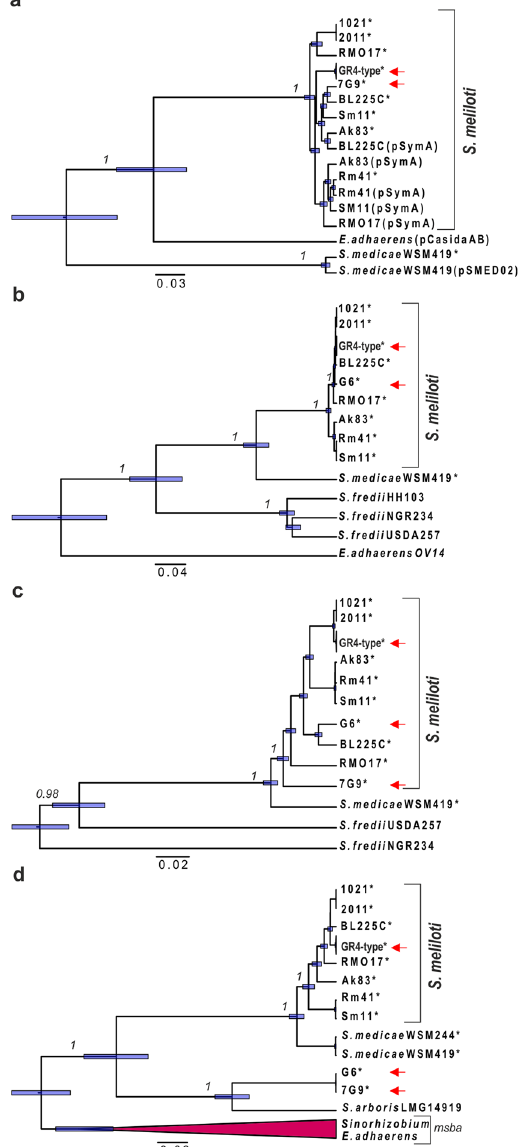
Figure 5. Species trees for GID core genes. The maximum clade credibility tree estimated with BEAST 2, based on the alignment of core loci (Supplementary Data 4–7) located at the left and right boundaries of the GID, and internal genes with higher levels of nucleotide diversity conserved in Sinorhizobium species. ( a ) Peptidase T (left boundary, WP_015243214.1). ( b ) Diguanylate cyclase (right boundary, WP_015243358.1). ( c ) Sensor histidine kinase (WP_015243309.1) within Region 5. ( d ) multidrug ABC transporter ATPase/ permease (WP_015243259.1) within Region 3. We included paralogous msba (collapsed branches) gene sequences (homologous to E. coli msba gene encoding Lipid A export ATP-binding/permease protein) in the alignment, to improve the definition of the phylogenetic position of the locus harbored by the isolates. Node bars indicate the 95% credibility intervals (95% HPD) for node ages. The scale bar represents the number of nucleotide substitutions per site. The asterisks ( * ) indicate location in pSymB and orthologous plasmids, and the red arrows identify GR4-type isolates and the isolates G6 and 7G9. The names of the other plasmids present are given in